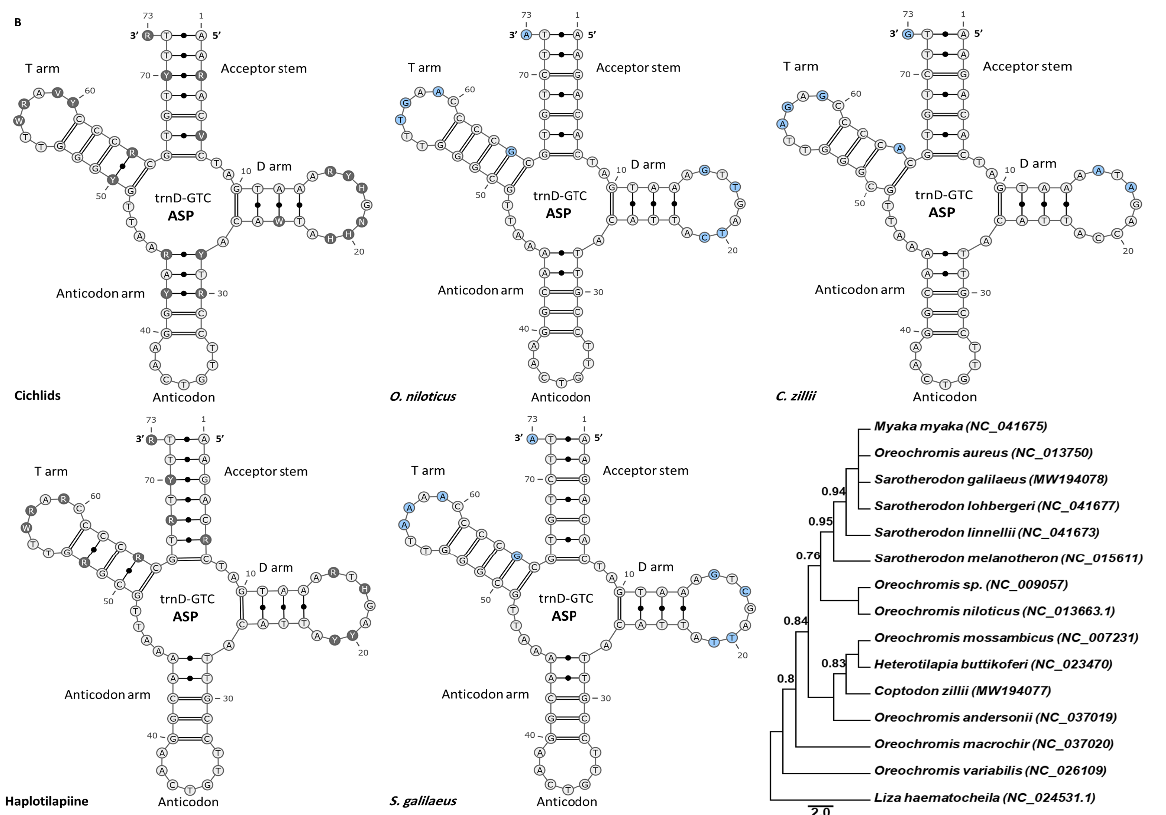
Figure 5. Superimposition of secondary structures of mitochondrial trnC ( A ) and trnD ( B ) molecules, showing the distribution of polymorphic sites among cichlids, haplotilapiine, and three species represents haplotilapiine species ( O. niloticus , C. zillii , and S. galilaeus ) abundant in the Nile River and connected waterbodies in Egypt. The tRNA genes are labeled with the abbreviations of their corresponding amino acids. The numbers indicate the position in the structure. Degenerated nucleotides are used, which is represented as a colored circle. The polymorphic nucleotides observed in cichlids and haplotilapiine are gray circles, while light blue circles correspond to polymorphisms in each species. Maximum likelihood phylogenetic tree based on trnC ( A ) and trnD ( B ) of haplotilapiine group. Liza haematocheila served as an outgroup species. Numbers beside internal branches indicate bootstrap value. GenBank accession numbers are listed between brackets.